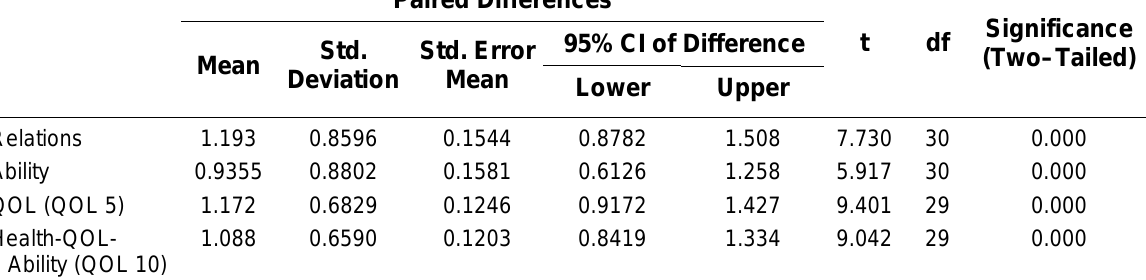
Paired Sample Test Paired